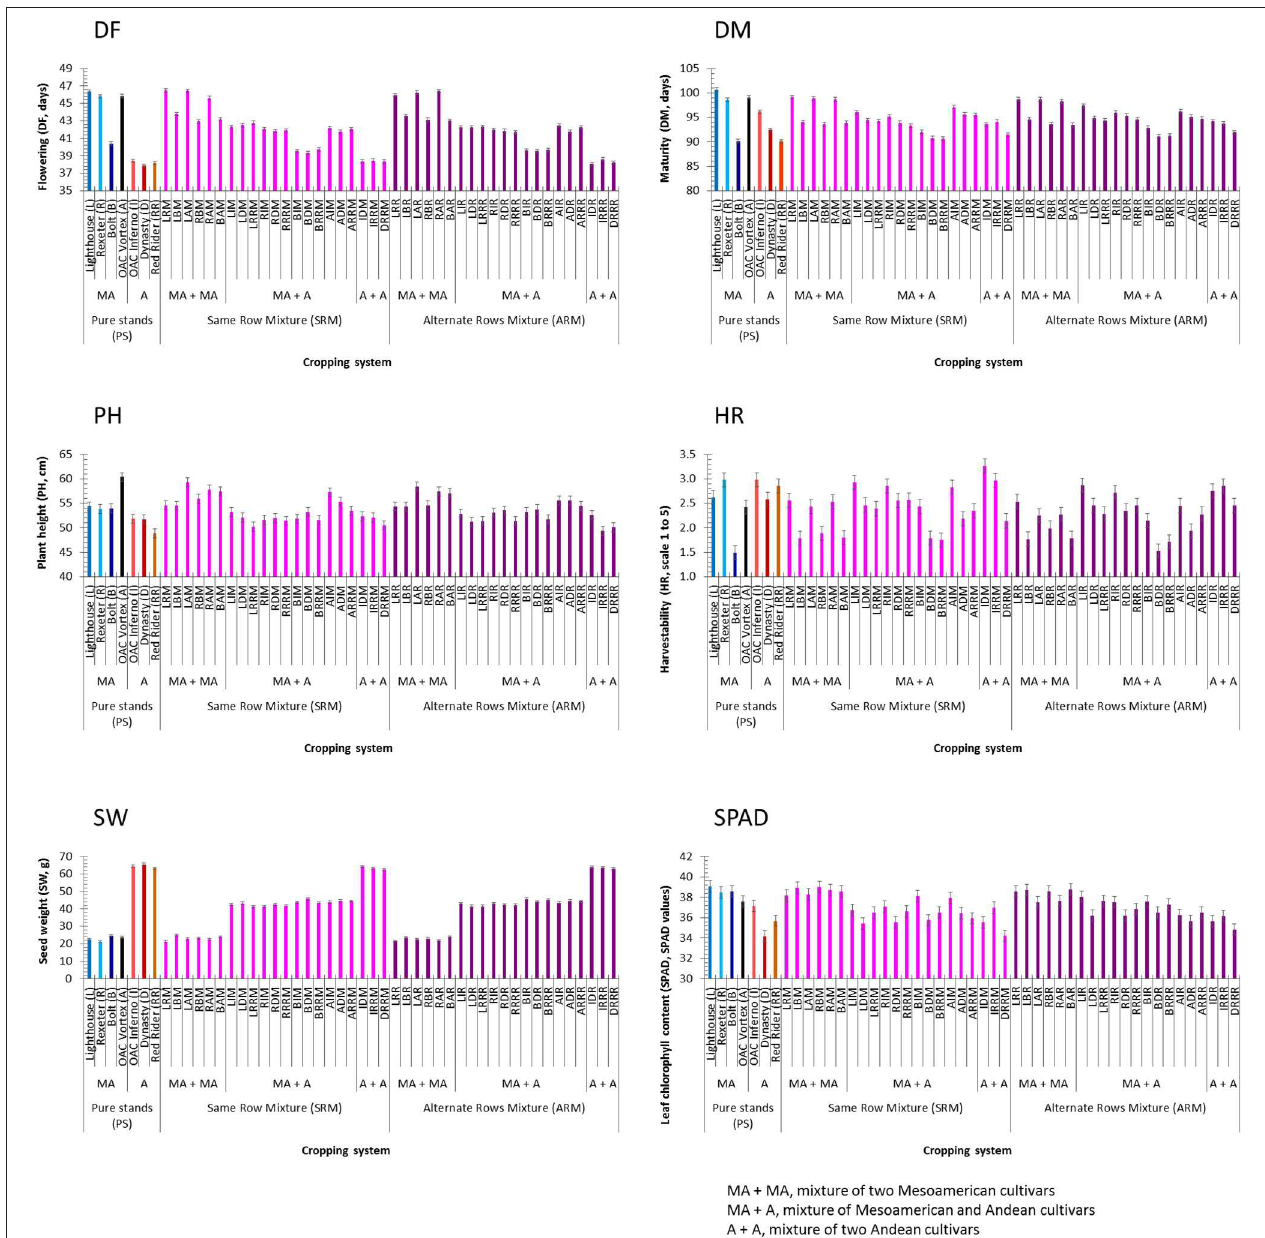
FIGURE 4 | Trait means and standard errors of the seven bean genotypes evaluated in pure stands and binary mixtures [same row mixture (SRM) and alternate rows mixture (ARM)] averaged over three Ontario environments/locations in 2018. Traits: days to flowering (DF, days), days to maturity (DM, days), plant height (PH, cm), harvestability (HR, scale 1 to 5), seed weight (SW, g), leaf chlorophyll content (SPAD, SPAD values)]. In each histogram, cropping system [seven cultivars in pure stands, 21 SRMs (same row mixtures) and 21 ARMs (alternate row mixtures)] and gene pool [MA, Mesoamerican; A, Andean; MA + MA, mixture of two Mesoamerican cultivars; MA + A, mixture of Mesoamerican and Andean cultivars; A + A, mixture of two Andean